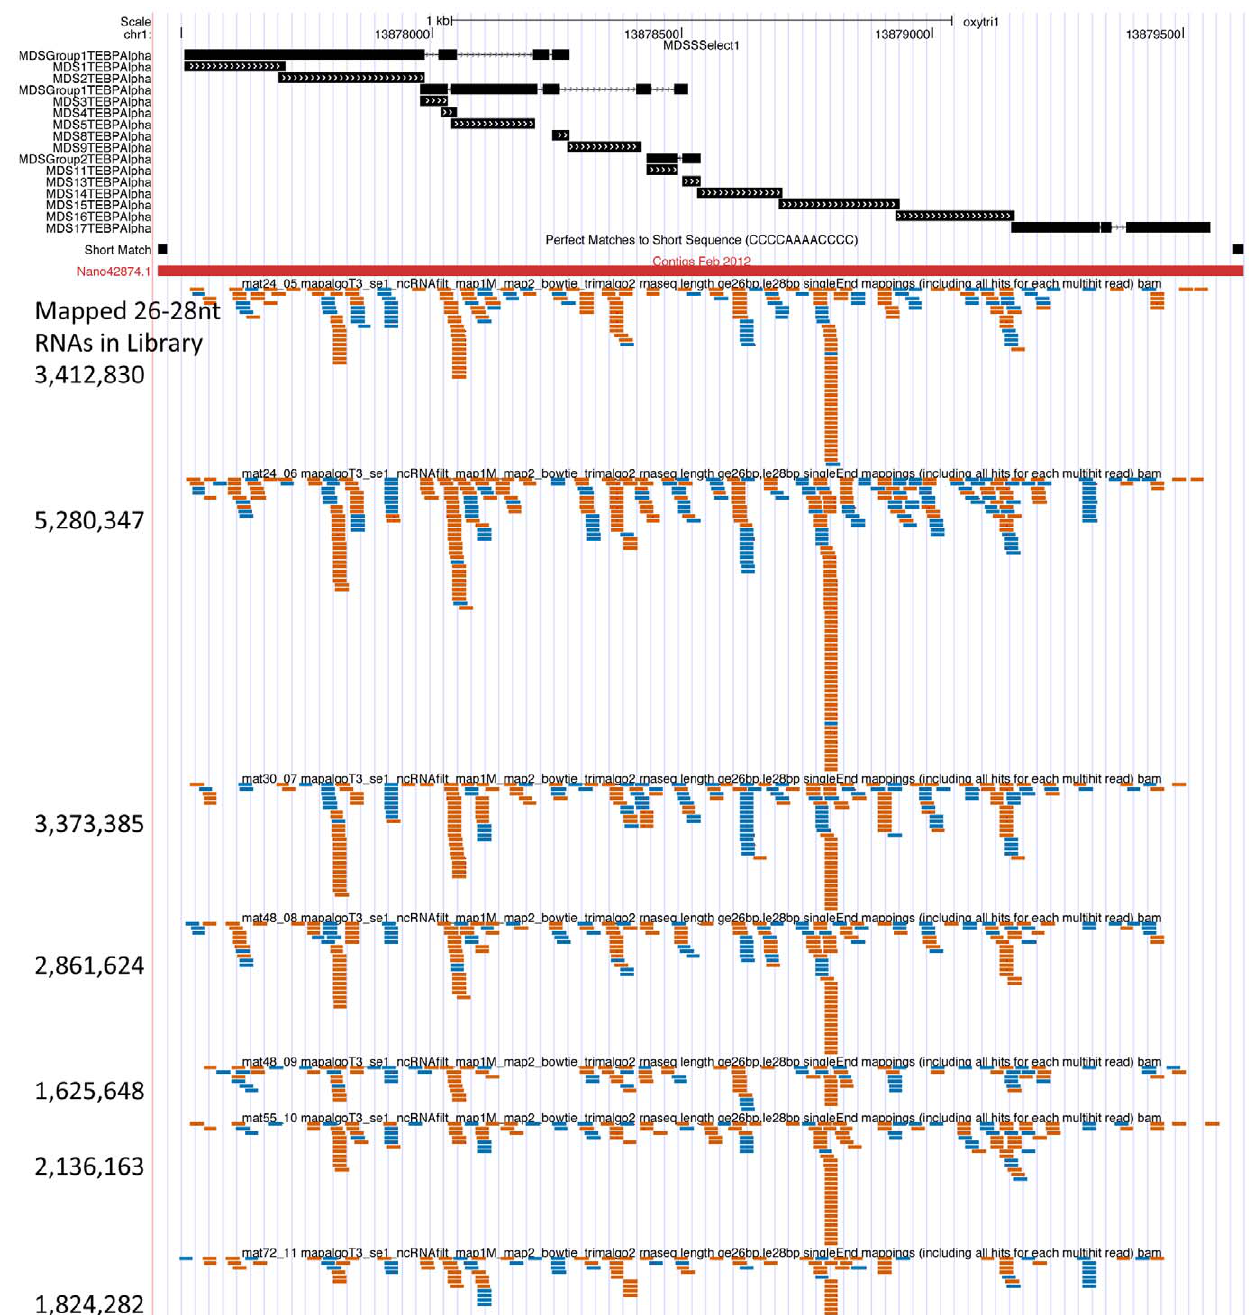
Figure 6. 27 nt RNA reads from different mating libraries align to both strands of a nanochromosome. This screen shot from the Oxytricha trifallax macronuclear genome build of the UCSC Genome Browser shows the macronuclear nanochromosome corresponding to the alpha telomere binding protein gene indicated as a red bar (Nano42874.1) with the telomere sequences at the beginning and end of the nanochromosome noted as small black boxes in the track above that. The top track shows the locations of groups of MDS sequences or individual MDSs, as aligned using BLAT of the micronuclear sequence against the macronuclear genome. The alignments of 26–28 nt small RNAs from 7 different mating small RNA libraries (mat24_05, mat24_06, mat30_07, mat48_08, mat48_09, mat55_10 and mat72_11 - see Table 1) are shown with alignments to the plus strand of the nanochromosome indicated in blue and alignments to the minus strand of the nanochromosome indicated in orange. Numbers at the left indicate the total number of 26, 27 and 28 nt RNA sequences from each of the seven libraries that mapped to the macronuclear genome. doi:10.1371/journal.pone.0042371.g006 for the 27 nt small RNAs, aligned to either strand, relative to the nanochromosomes from chr1 that were at least 500 bp in length. rest of the nanochromosome. To quantify this, we determined the For each of these nanochromosomes, we measured the density of average 26–28 nt coverage density of each of 10,002 complete 5 9 ends of 26–28 nt small RNAs at each of the proximal 500 nt